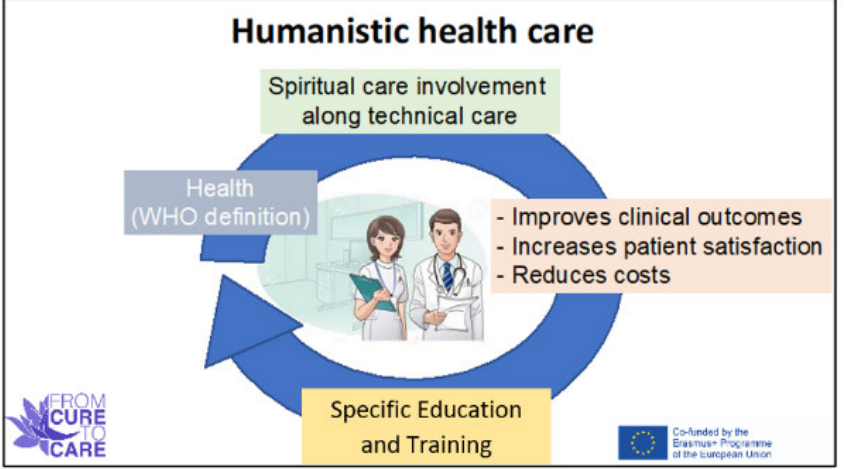
Figure 1. Achievement of humanistic healthcare by doctors and nurses.